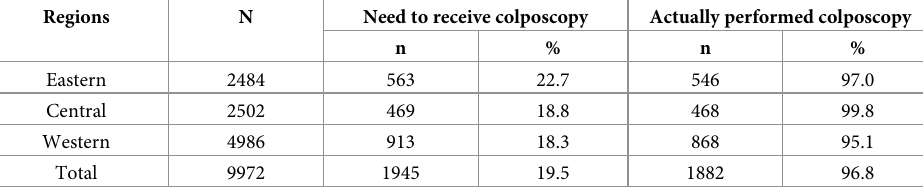
Table 2. Situation of follow-up of colposcopy and CIN2+ detection in different regions of China. Regions N Need to receive colposcopy Actually performed colposcopy